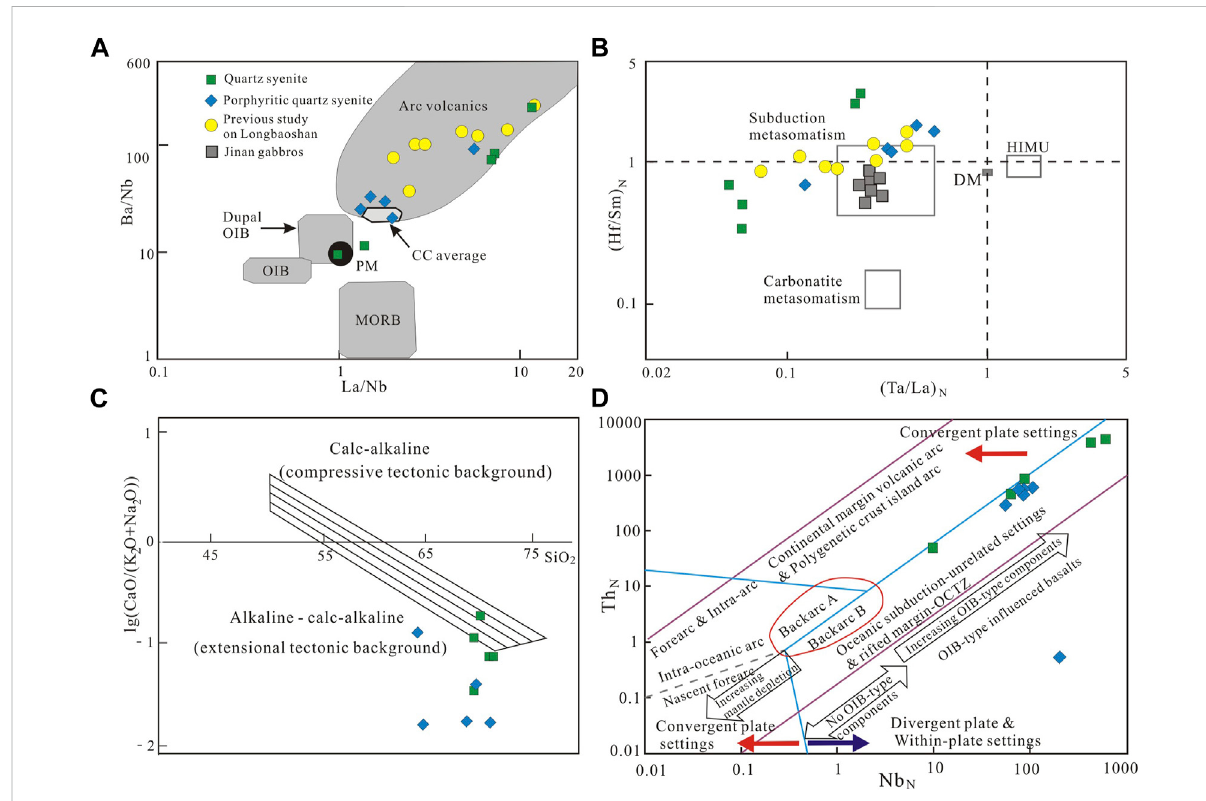
FIGURE 9 (A) La/Nb versus Ba/Nb diagram for the Chishan and Longbaoshan complexes. The fi elds of MORB, PM, OIB, Dupal OIB, continental crust (CC) average, and arc volcanics are referred to Jahn et al. (1999). (B) (Ta/La) N versus (Hf/Sm) N diagram for the Chishan and Longbaoshan complexes. The trends of the subduction- and carbonatite-related metasomatism are from La Flèche et al. (1998). (C) SiO 2 versus lg (CaO/(K 2 O + Na 2 O)) discrimination diagrams ofthequartzsyenitefrom theChishan and Longbaoshan complexes(after Pearce, 1996). (D) Nb N versusTh N diagrams for the Chishan and Longbaoshan complex (after Saccani,